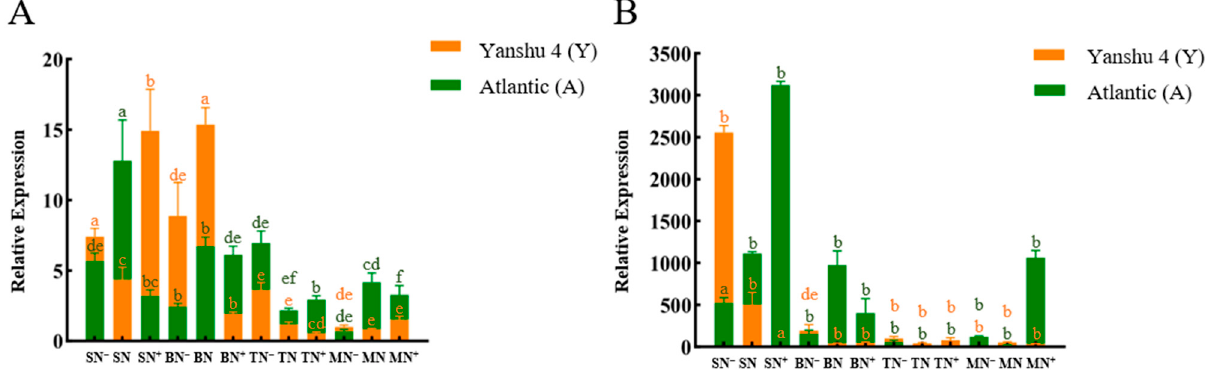
Figure 14. Relative expression of nitrate transporter StNRT2.7 in two genotypes of potato under different N supply levels. ( A ) Leaf (L); ( B ) Root (R). S, B, T, and M represent seedling stage, budding stage, tuber expansion stage, and mature stage, respectively. N − , N, N + are different N supply levels, representing low N, normal N, and excess N, respectively. Different letters indicate the difference of relative gene expression in different periods under different N application levels ( p < 0.05).